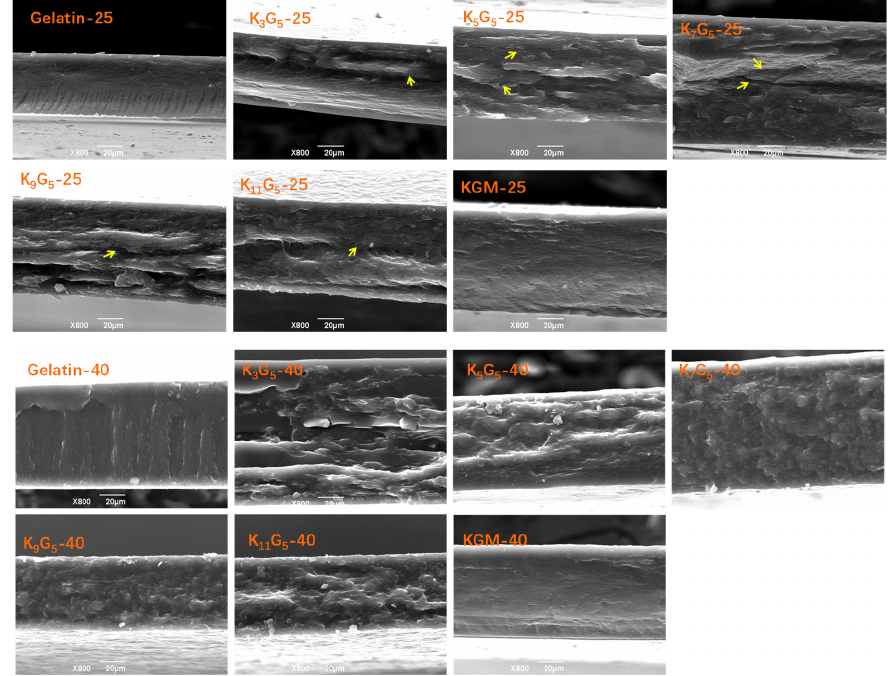
Figure 1. SEM images of konjac glucomannan (KGM), gelatin, and KGM/gelatin films formed under different drying temperatures.